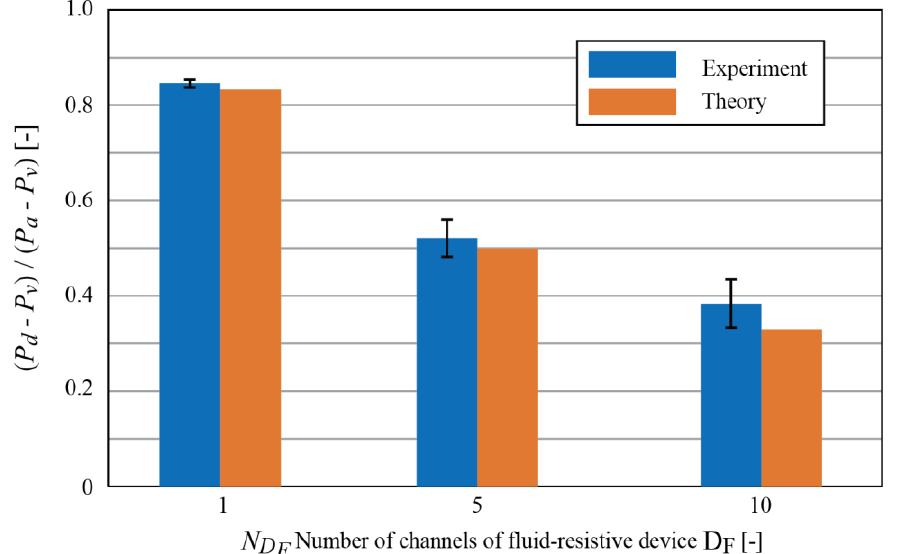
Figure 8. Ratio of the pressure drop in the hemofiltration device D H and the fluid-resistive device D F as a function of the number of the channels of D H . The theoretical value was deduced from Equation